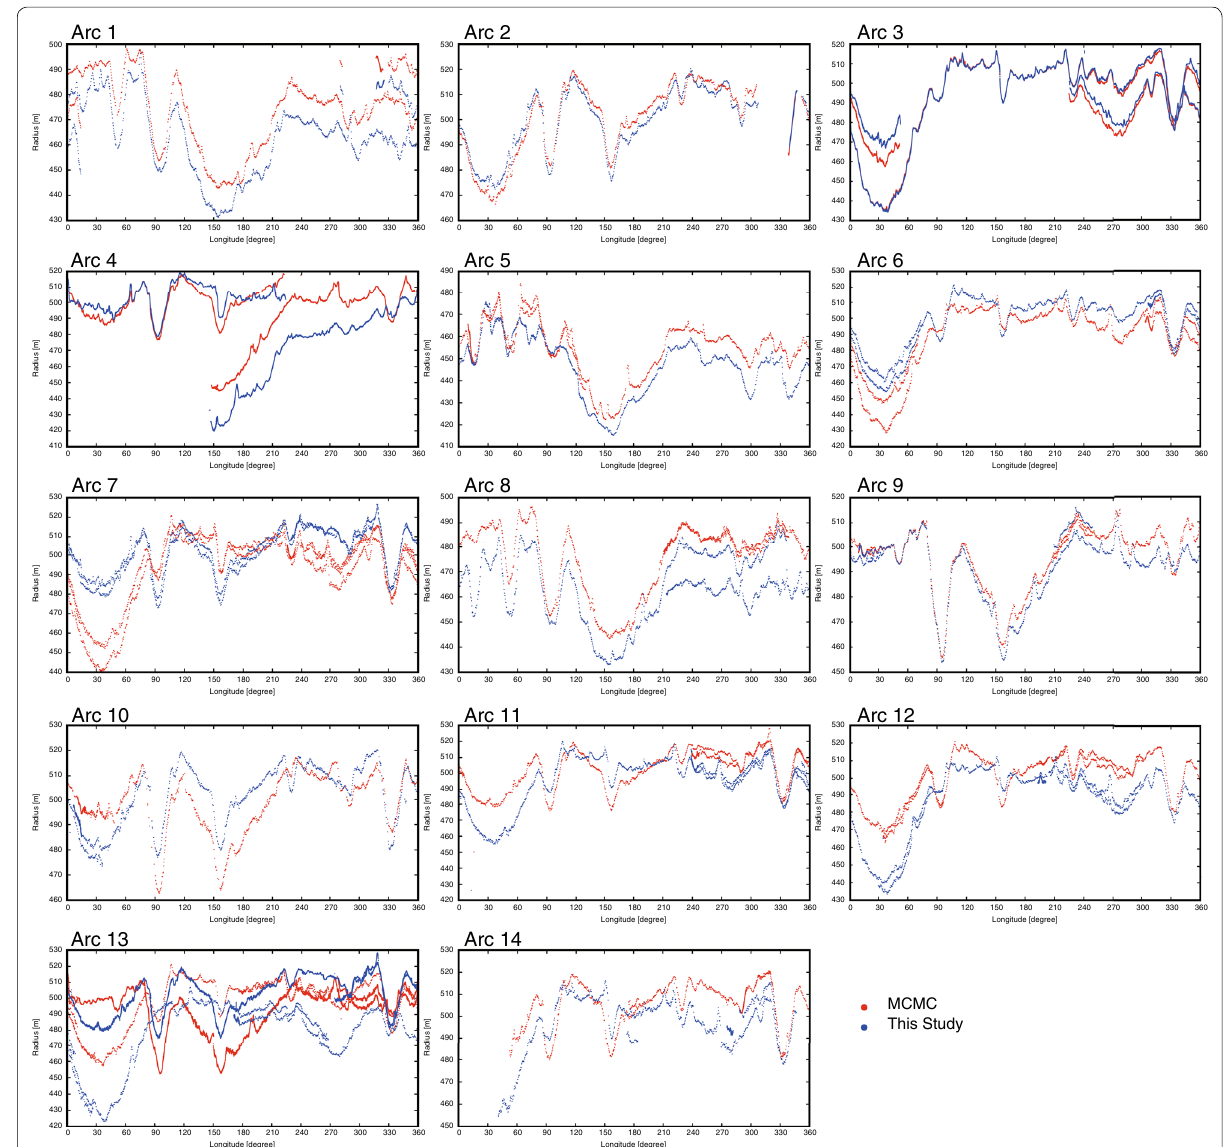
Fig. 8 Topographic profiles of the Ryugu shape model along with the LIDAR footprints of the MCMC orbit presented by Matsumoto et al. (2020) (red) and our determined orbit